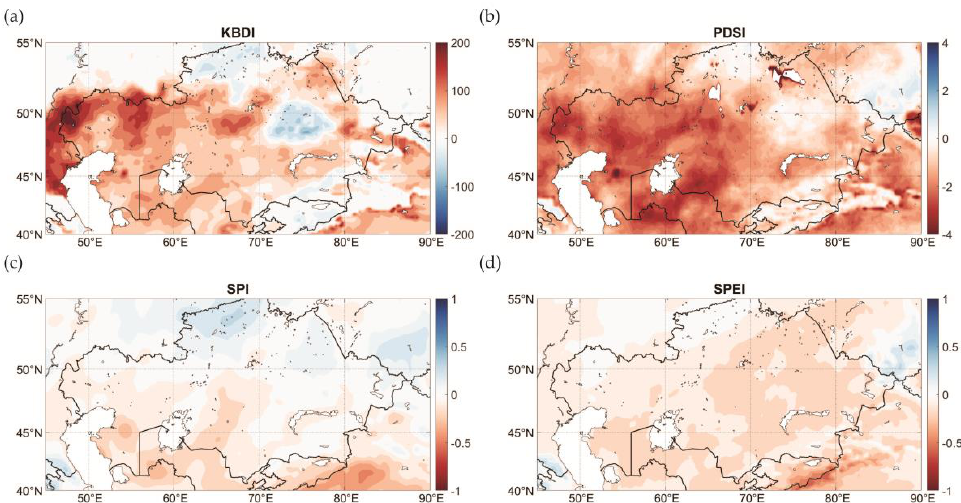
Figure 5. The spatial distribution of the differences between mean KBDI ( a ), PDSI ( b ), SPI ( c ) and SPEI ( d ) averaged over the periods 2001 – 2021 and 1979 – 2000 in spring (MAM). The spatial pattern of the KBDI difference between selected time intervals (2001 – 2021 and 1979 – 2000) is characterized by strong positive differences in the western and north- western parts of the country and negative differences in its northern and central regions. It does not change significantly between spring and summer (Figures 5a and 6a). The greatest increase in fire risk in the 21st century was observed to the north of the Caspian and Aral Seas. It is noteworthy that these regions are not characterized by maximum val- ues of KBDI that are located in the south, southwest and in the center of Kazakhstan (Sup- plementary materials, Figure S1). The biggest difference between the two selected time intervals was revealed in the PDSI values. At the end of the 20th century, PDSI had slightly positive or almost zero values, which coincided with normal moisture conditions (Supplementary Materials, Fig- ure S2a,c). In the 21st century, PDSI was significantly decreased over the entire territory of Kazakhstan, which corresponded to an increase in aridity, both in the spring and sum- mer seasons (Supplementary Materials, Figure S2b,d). The maximum PDSI differences (up to 4 units) between the early 21st and late 20th centuries occurred in the southern, southwestern, western and most central parts of Kazakhstan (Figures 5b and 6b). The changes in the PDSI values from 0 up to −4 correspond to the transition from normal to extremely arid conditions (Table 2). An exception is the north of the country, where suffi- cient or episodically wet moisture conditions remained in the early 21st century. The spatial patterns of SPI differ from the KBDI and PDSI patterns. Analysis shows that aridity does not increase in spring over Kazakhstan, while in the early 21st century, the northern regions were characterized by more humid conditions than in the late 20th century (Figure 5c). The situation changed drastically in the summer of the early 21st cen- tury when aridity increased everywhere except in the central and northern regions (Figure 6c). The maximum difference between the early 21st and late 20th centuries was observed in northwestern and southwestern regions, i.e., in the areas characterized by the highest aridity. SPEI experienced a slight decrease over the study period both in spring and summer, which coincides with aridity growth. The spatial patterns were not similar during these two seasons, with a maximum difference between two time intervals observed in the east- ern part of Kazakhstan in the spring (Figure 5d) and the western part in the summer (Fig- ure 6d). In the spring, the SPEI fell into a gradation of normal moisture conditions over